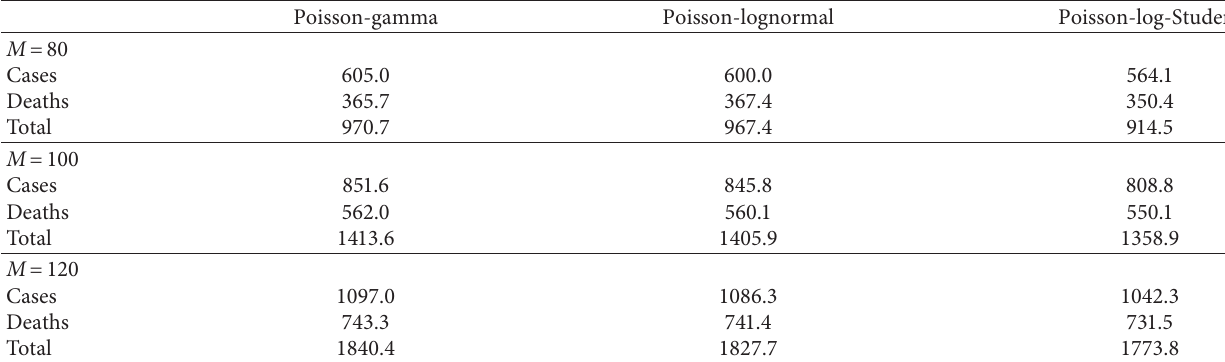
Table 2: Fit to training data (WAIC criterion).